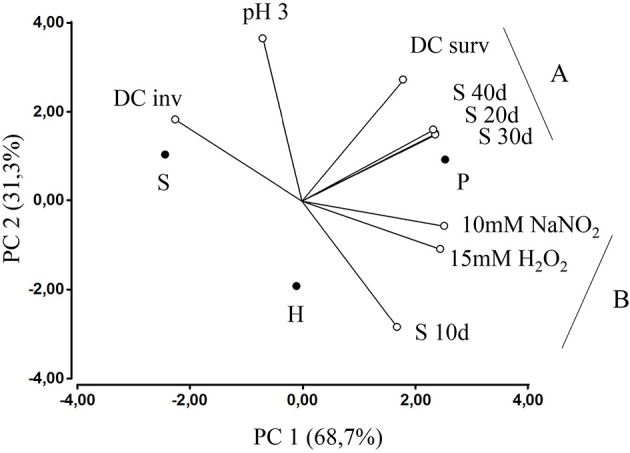
Principal components analysis (PCA) showing the association between Salmonella enterica ser. Enteritidis hosts (displayed as filled circles) and results of phenotypic assays (displayed as linear axes and empty circles). In parenthesis appears the variability associated to each principal component (PC). S, seabirds; H, human; P, poultry; DC inv, invasion to dendritic cells; DC surv, survival within dendritic cells; pH3, survival to acidic pH; S, starvation assay (10–40 d, 10 to 40 days); 15 mM H2O2, survival to reactive oxygen species; 10 mM NaNO2, survival to reactive nitrogen species.